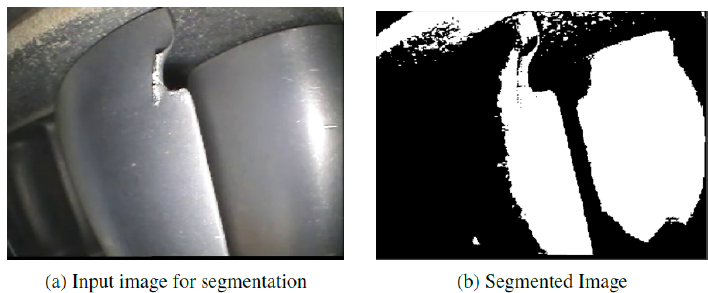
Figure A11. Precision–recall curve for the Random Forest model based on feature engineering.